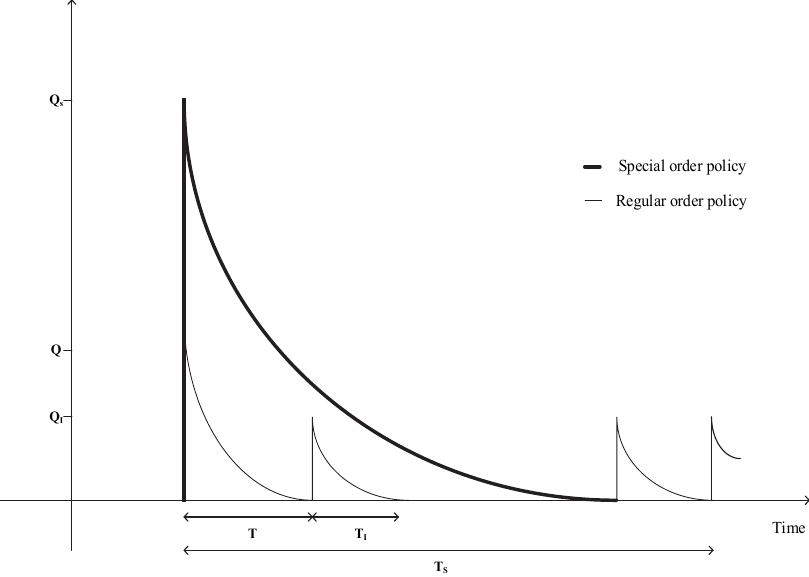
Fig. 1. Special vs. regular order policies when the special order time coincides with the retailer’s replenishment